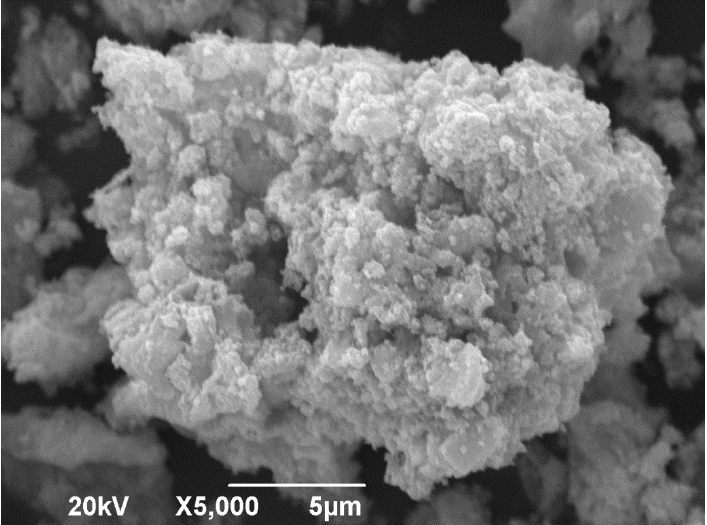
Figure 5. SEM micrograph of the SnO-GO.